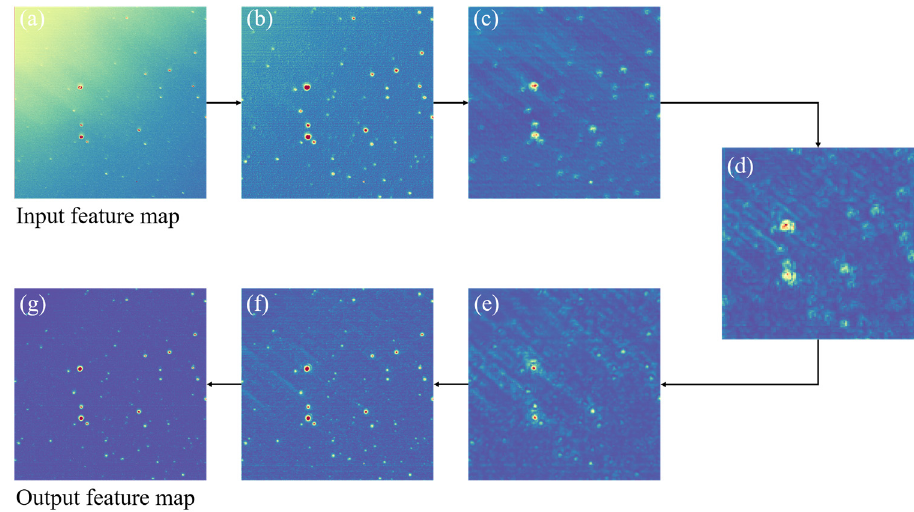
Figure 9. Intermediate results of the BSC-Net processing images. ( a ) Input feature map. ( b ) Feature map with 128 channels. ( c ) Feature map with 256 channels. ( d ) Feature map with 512 channels. ( e ) Feature map with 256 channels after skip connection. ( f ) Feature map with 128 channels after skip connection. ( g ) Output feature map.